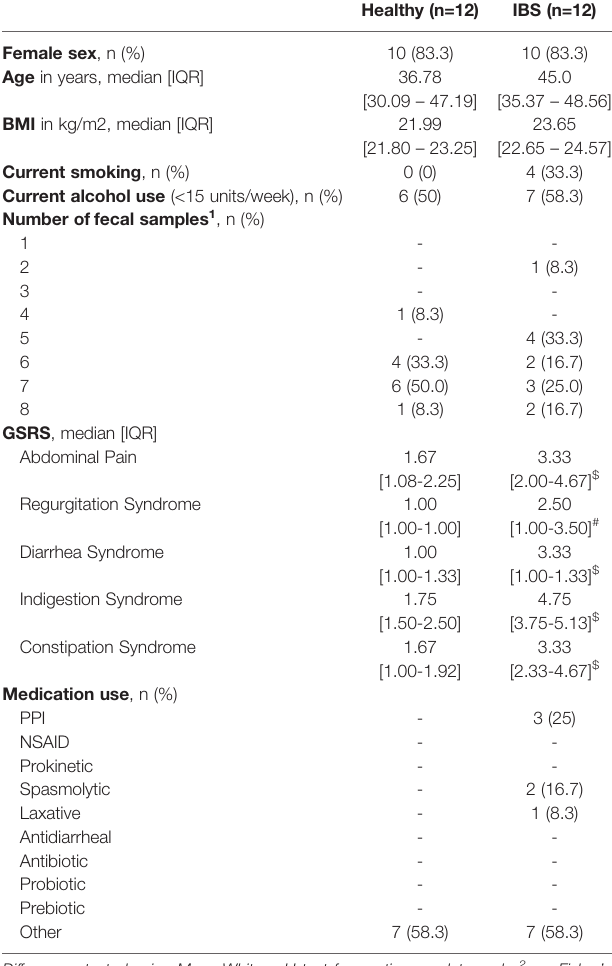
TABLE 1 | Demographic